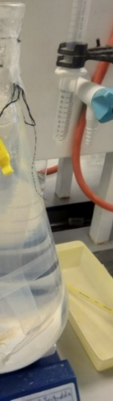
Figure 2. Dialysis of GelMA against DI at 50 °C for 1 week; three dialysis bags are shown in this figure.